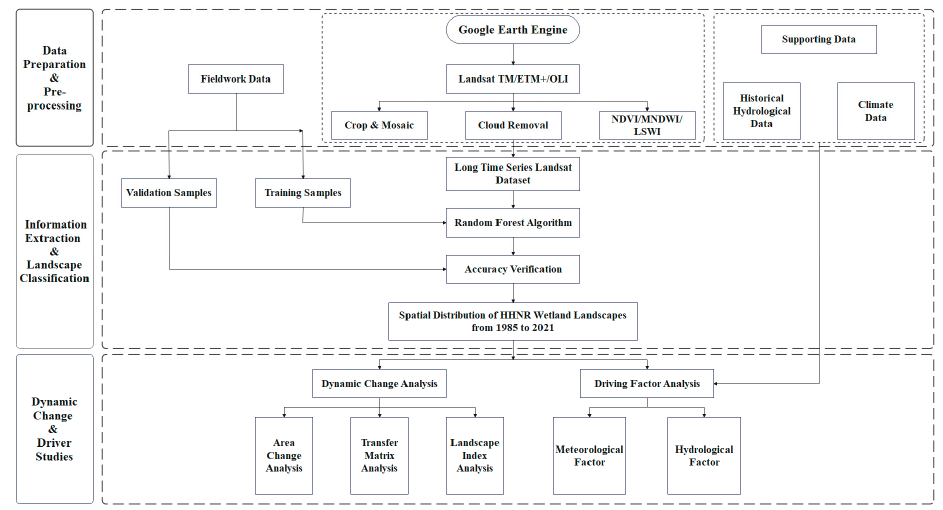
Figure 2. The flow chart of the method used in this study.